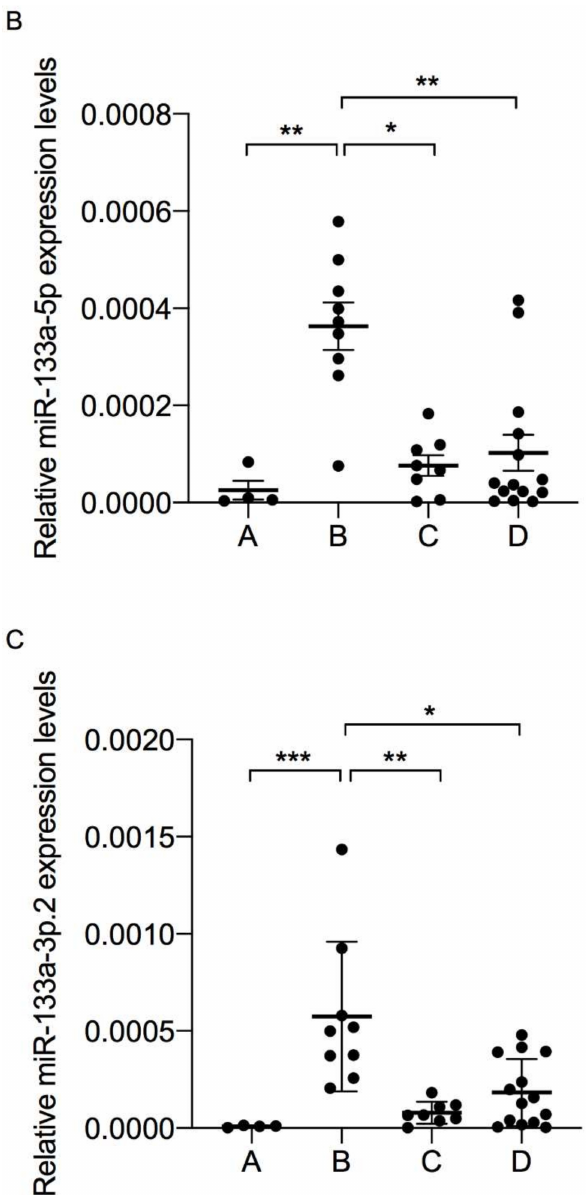
Figure 2. Total microRNAs were extracted from extracellular vesicles plasma-derived of chronic obstructive pulmonary disease (COPD) patients, and miR-206 ( A ), miR-133a-5p ( B ), and miR-133a-3p.2 ( C ) levels were measured by qPCR, analysis using the Ct method, and normalized to Cel-miR-39. Kruskal–Wallis followed by Dunn’s multiple comparisons test (* p < 0.05, ** p < 0.01, *** p <